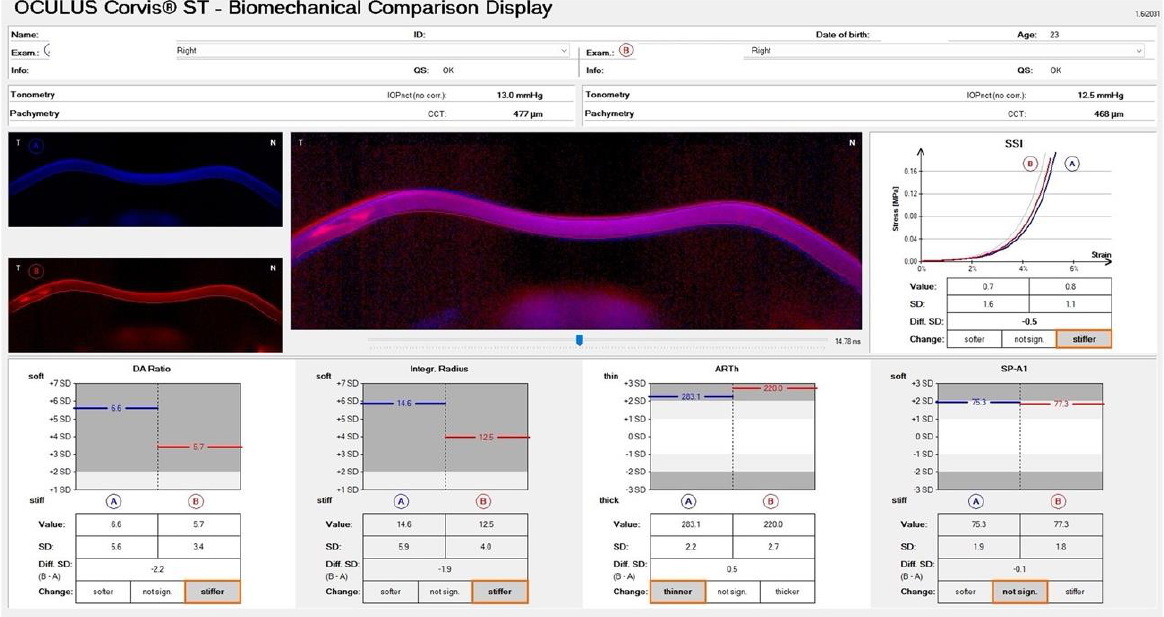
Figure 6. ( A ). Slit-lamp biomicroscopy of the Keraring AS (Mediphacos, Belo Horizonte, Brazil) ICRS and its position with the OCT in ( B ), demonstrating the progressive thickness profile.